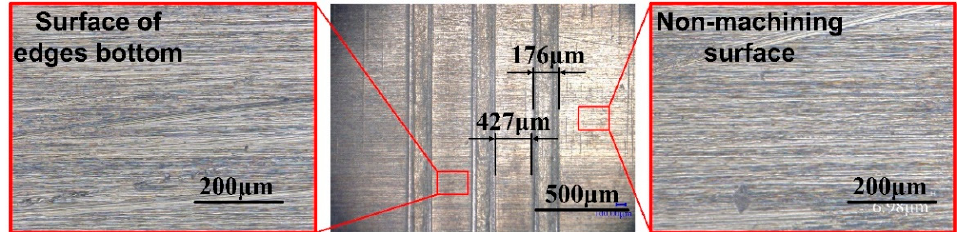
Figure 12. Photographs of the array micro-grooves using three-edges disk tool electrode.